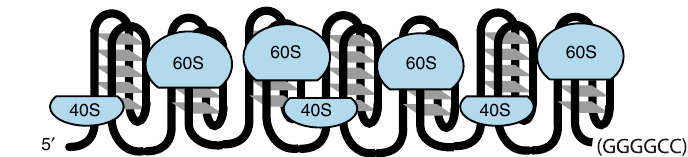
Fig. 8 Model of translation mechanisms associated with G 4 C 2 expansions in C9ORF72 ALS/FTD. ( a ) Pre-Initiation ribosomal complex (PIC) assembles on the 5 ′ cap of mRNA by interacting with eIF4F complex formed by the cap binding factor eIF4E, the platform eIF4G and the RNA helicase eIF4A. The PIC complex scans the 5 ′ end for an appropriate AUG start codon, where the 60S ribosomal subunit joins the 40S to form a functional 80S ribosome ready to translate the coding sequence. ( b ) G 4 C 2 RAN translation initiation shares the same pathway as the canonical one to translate poly-GA dipeptides, including the need of 5 ′ cap, eIF4E, eIF4G, eIF4A, initiator methionyl-tRNA, and the scanning mechanism. However, it initiates on a near-cognate CUG codon embedded in a perfect Kozak sequence, in frame with poly-GA, instead of a canonical AUG start codon. The ability of G 4 C 2 expansions to form stable G- quaduplex structures forces the ribosome to occasionally undergo frameshifting to translate poly-GP and poly-GR in the +2 and +3 frames, respectively. ( c ) When G 4 C 2 repeats are expanded, a subset of C9ORF72 mRNA is mis-spliced retaining intron 1 with the repeats 35 . RAN translation from these RNAs is inhibited by a uORF that is translated canonically. ( d ) G 4 C 2 expanded transcripts associate with ribosomal subunits independently from their